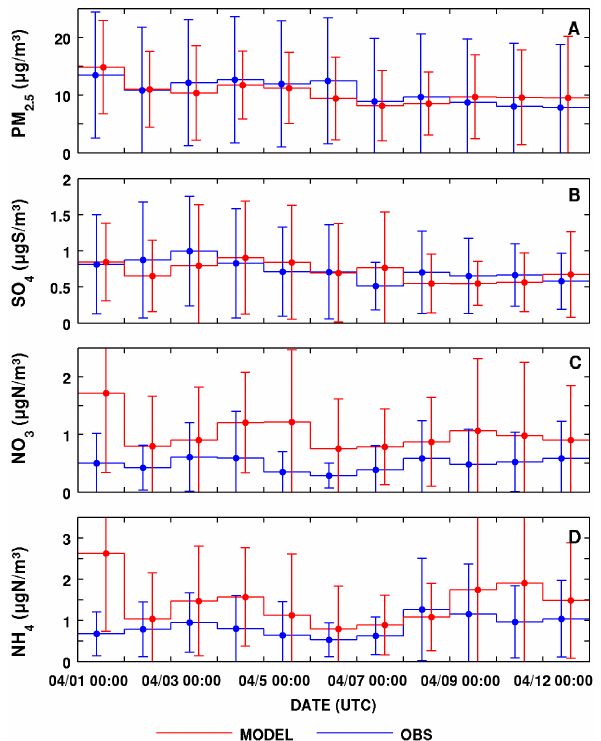
Figure 6. Daily mean aerosol mass measured at EMEP stations within the domain (in blue) and WRF-Chem aerosol mass extracted at the position of the stations (in red) for (a) PM 2 . 5 , (b) sulfate aerosol, (c) nitrate aerosol, and (d) ammonium aerosol. The stan- dard deviation between stations is indicated by the error